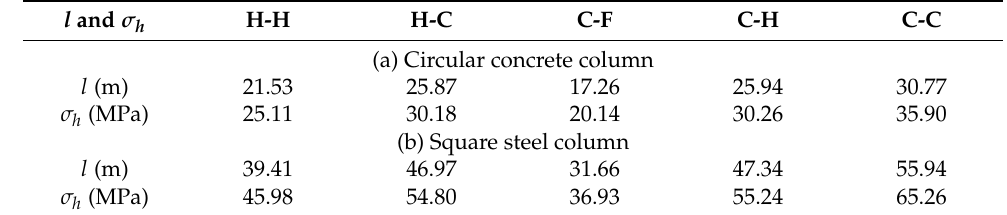
Table 6. Tallest buckling length * l and buckling stresses σ h of heavy columns * with compressive